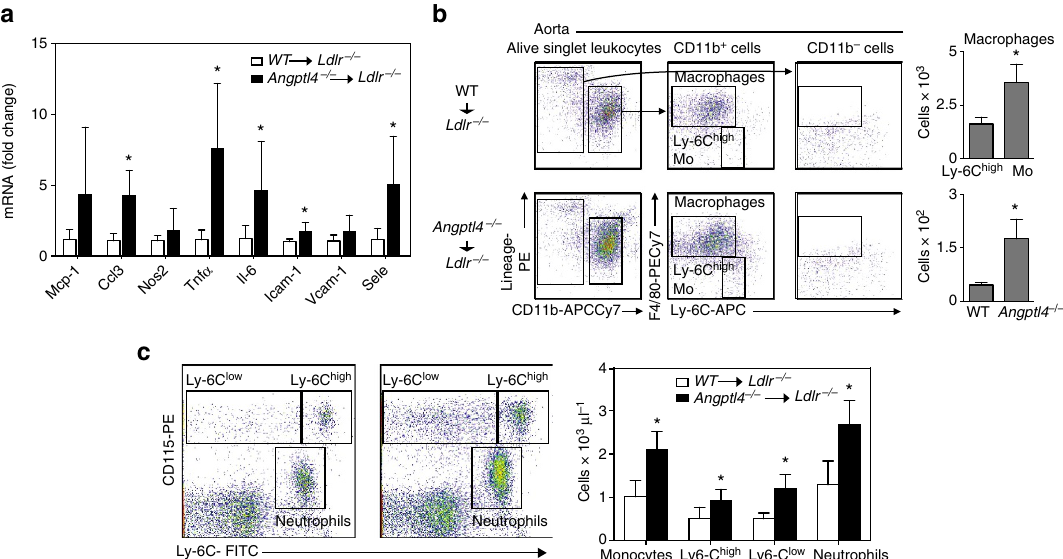
Figure 5 | Haematopoietic ANGPTL4 deficiency causes vascular inflammation and leukocytosis. ( a ) mRNA expression of inflammatory genes in the whole aorta of Ldlr (cid:2) / (cid:2) chimeras with WT or Angptl4 (cid:2) / (cid:2) BM after 12 weeks on WD ( n ¼ 9 per group). ( b ) Dot plots showing gating schemes of macrophages and monocytes from whole aorta of Ldlr (cid:2) / (cid:2) chimeras with WTor Angptl4 (cid:2) / (cid:2) BM after 12 weeks on WD. (right) The quantification of total number of macrophages and Ly-6C high monocytes ( n ¼ 6 per group). ( c ) Representative flow cytometry plots showing monocyte and neutrophil populations from Ldlr (cid:2) / (cid:2) chimeras with WTor Angptl4 (cid:2) / (cid:2) BM after 12 weeks on WD. Total monocytes and neutrophils are quantified on the right panel by extrapolating the proportion of cells from flow cytometry to the total number of leukocytes per m l measured using Hemavet haematology analyser ( n ¼ 10 per group). All data are the mean ± s.e.m.; * P o 0.05 by comparison with data from Ldlr (cid:2) / (cid:2) chimeras with WT BM by unpaired t